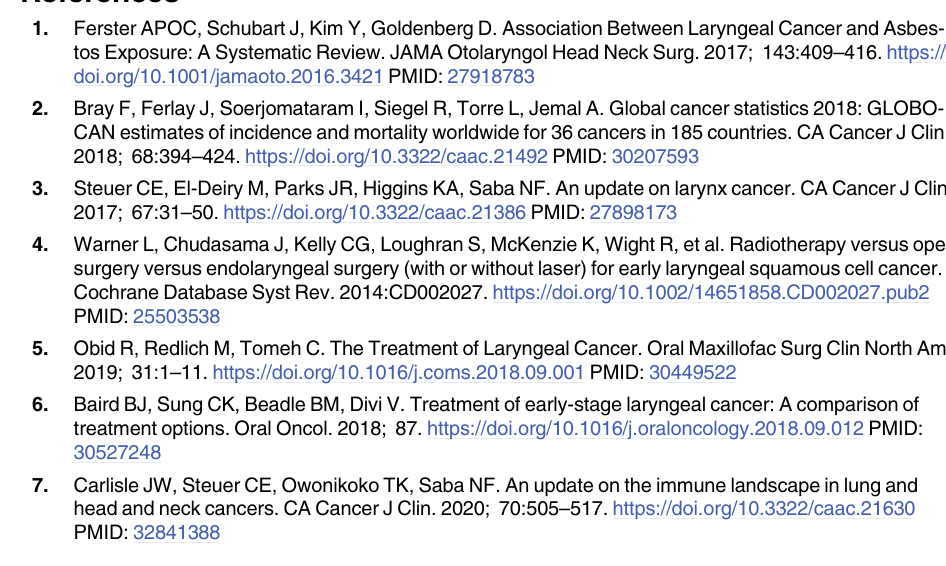
S6 Fig. Correlation between CIP4 expression and alcohol history. S7 Fig. Correlation between CIP4 expression and smoking history.